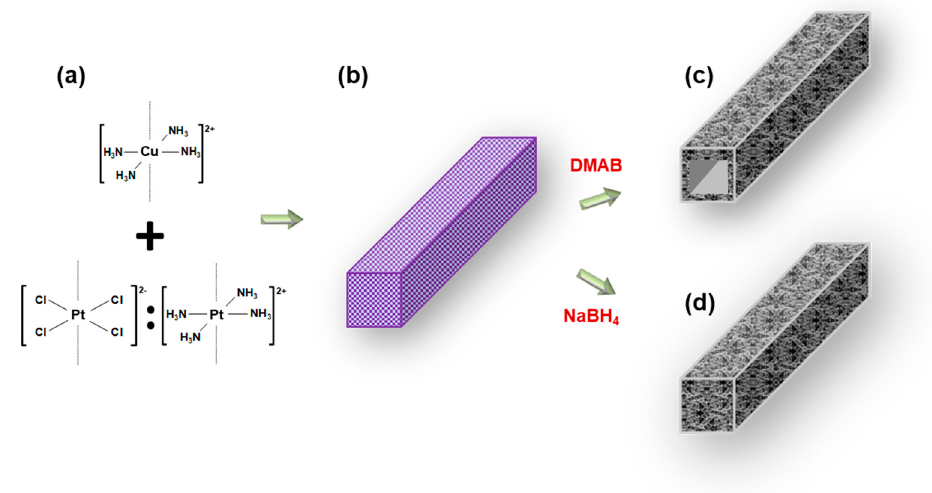
Figure 1. Platinum-copper porous macrotube–macrobeam synthesis scheme. ( a ) Addition of varying ratios of [Cu(NH 3 ) 4 ] 2 + with [PtCl 4 ] 2 − and [Pt(NH 3 ) 4 ] 2 + . ( b ) Linear stacking of platinum and copper square planar complex ions to form Magnus’s salt crystal derivatives. ( c , d ) Reduction of platinum-copper salt needle templates to (c) square cross-section macrotubes using dimethylamine borane (DMAB), or (d) porous macrobeams using NaBH 4 .